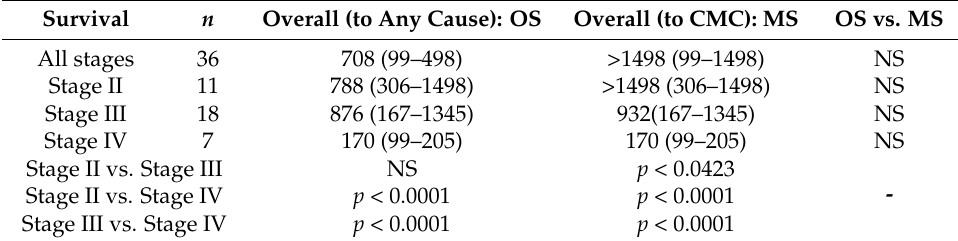
Table 2. Median overall survivals obtained from Kaplan-Meier data (Figure 3a,b).